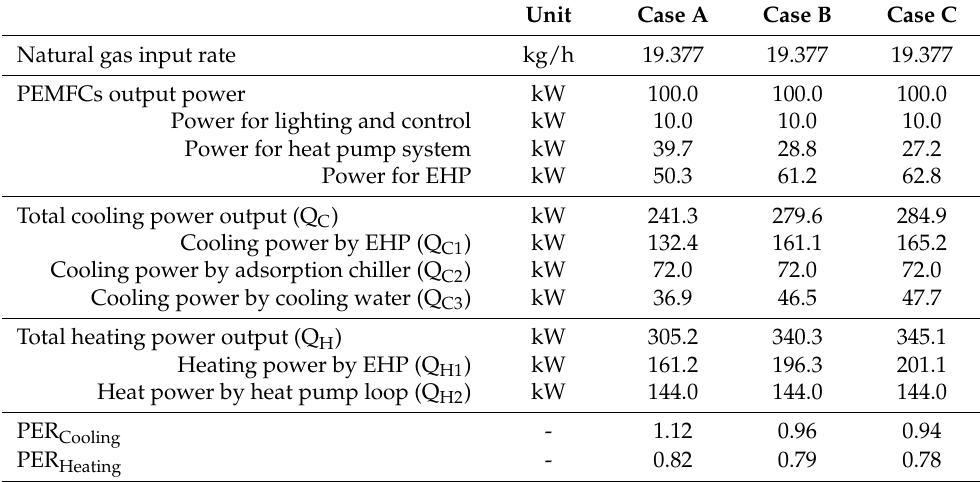
Table 3. Energy performance results of the proposed systems.